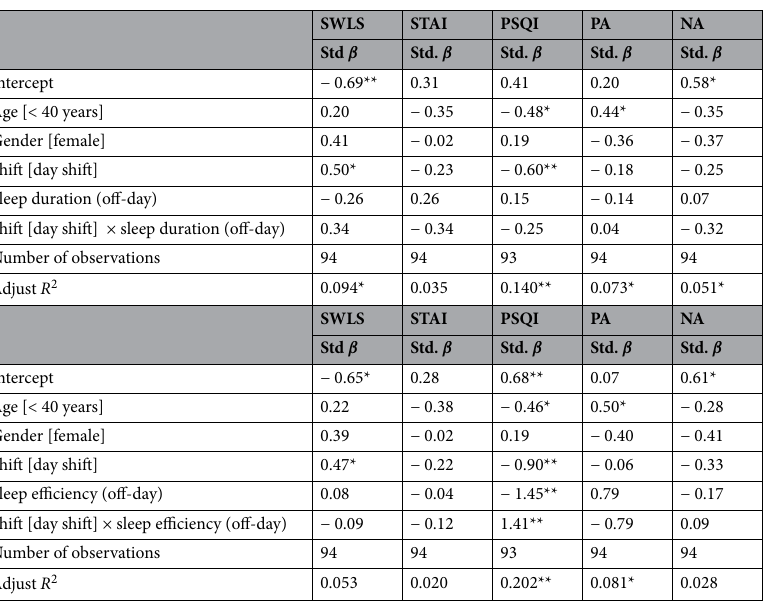
Table 5. Results from the linear regression models to predict pre-study self-report variables using the physical activity features. Statistical significance is denoted with ** p < 0.01 , * p < 0.05